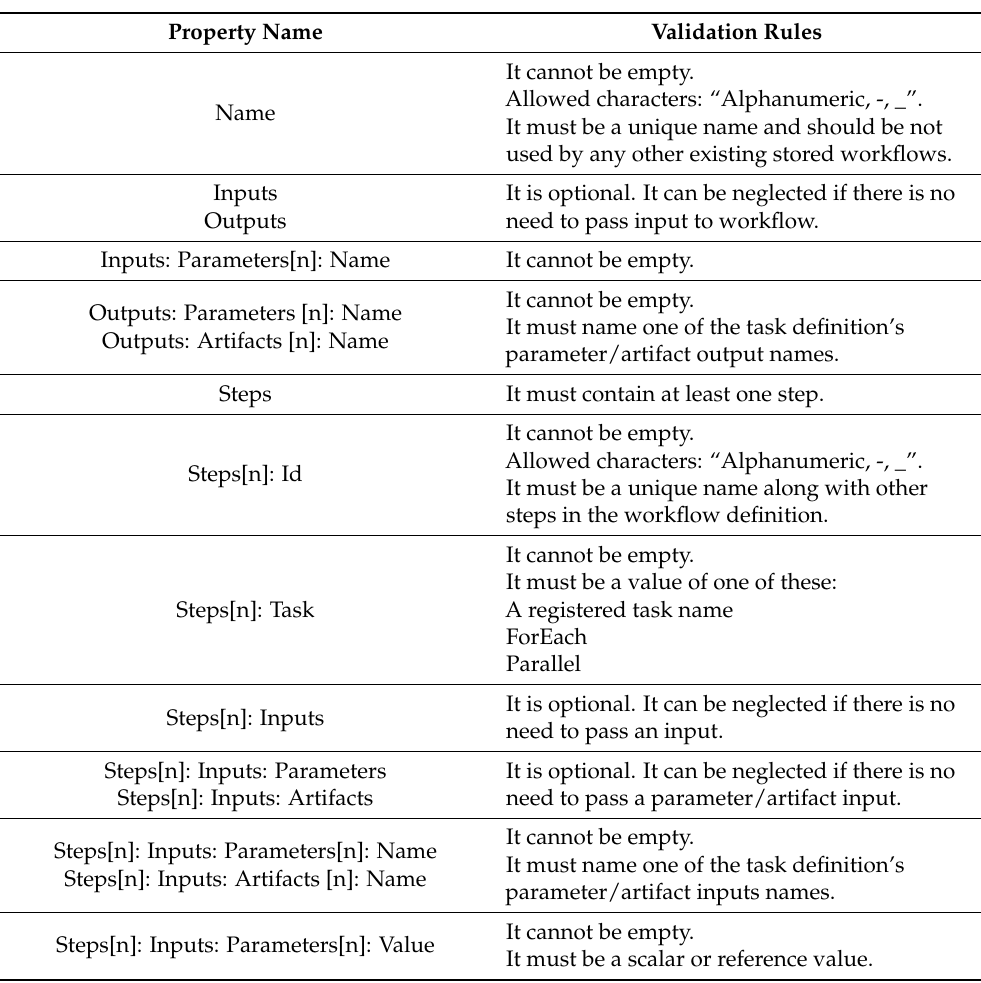
Table 2. Validation rules for workflow definition